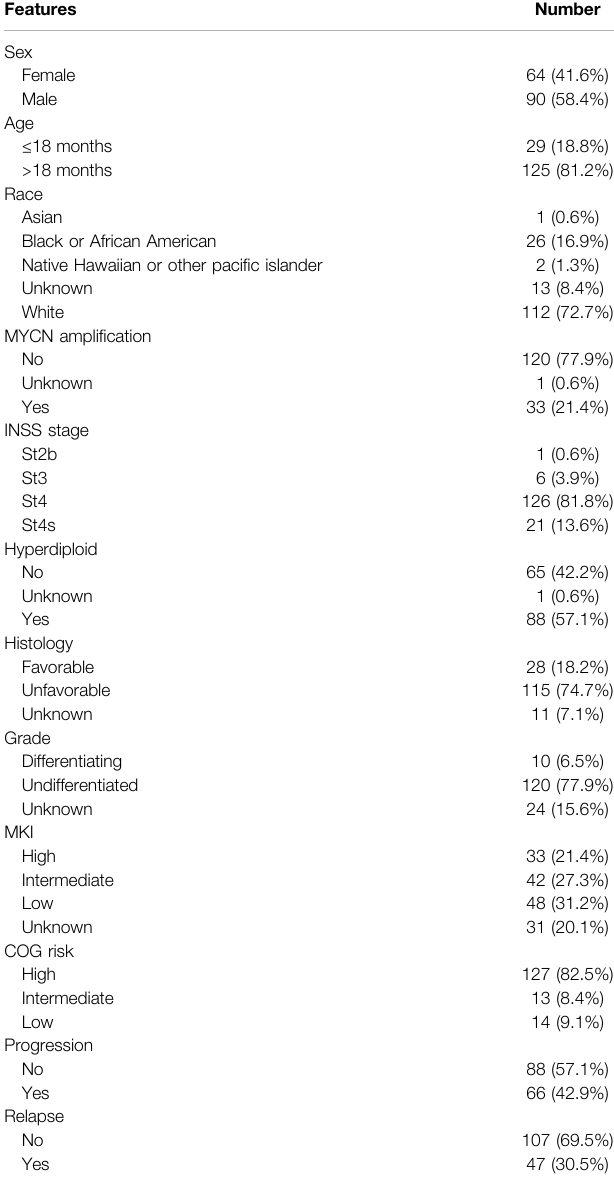
TABLE 2 | Clinical pathological parameters of NB patients in the validation set.